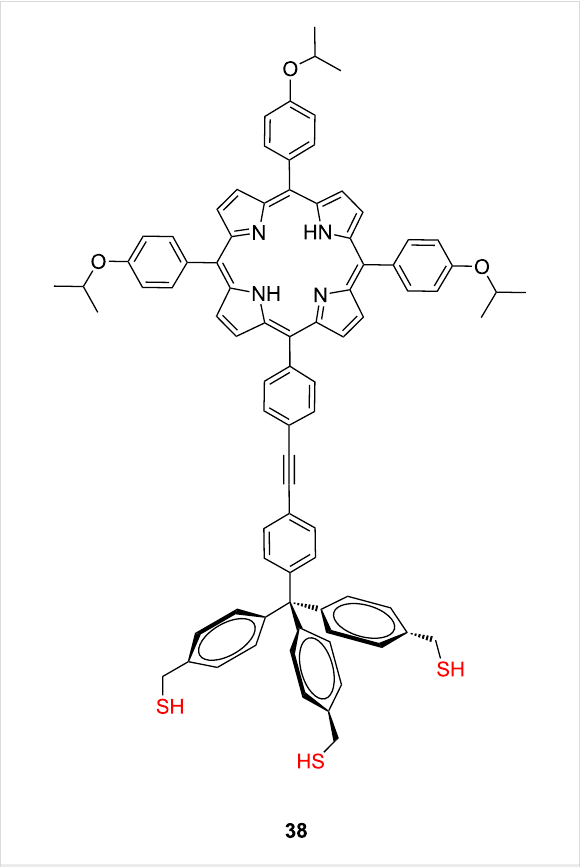
Figure 16: Self-decoupled porphyrin with a tetraphenylmethane scaf- fold 38 .